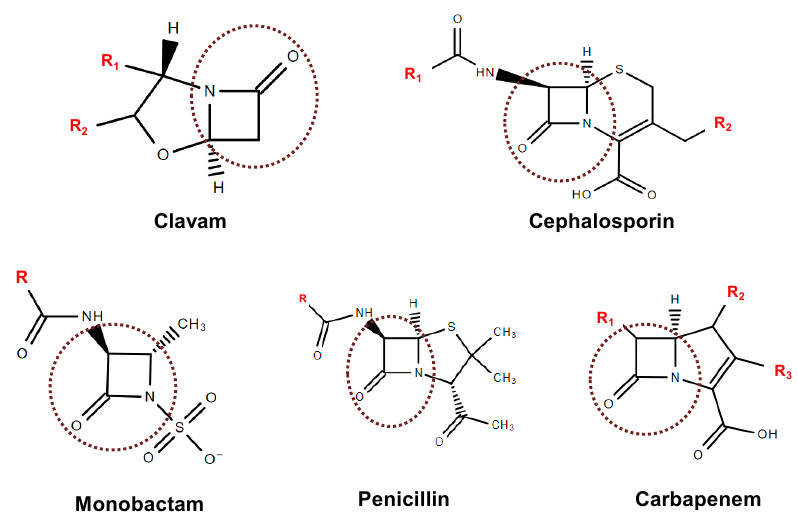
Figure 1. Backbone composition of β -lactam structures with the β -lactam ring highlighted (Structures drawn in ChemSpider).